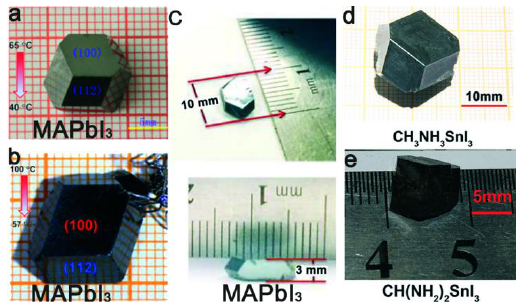
Figure 3. ( a , b ) Bottom seeded solution growth of MAPbI 3 single crystal perovskites with different temperature ranges resulting in different sizes; ( c ) Top seeded solution growth of MAPbI 3 single crystal; ( d ) MASnI 3 single crystal and ( e ) CH(NH 2 ) 2 PbI 3 single crystal. The figure was taken from